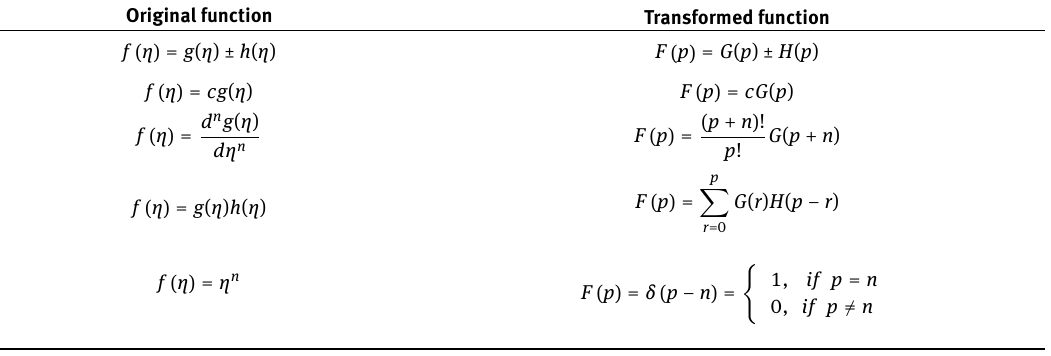
Table 1: Fundamental basic operations of DTM [38] Original